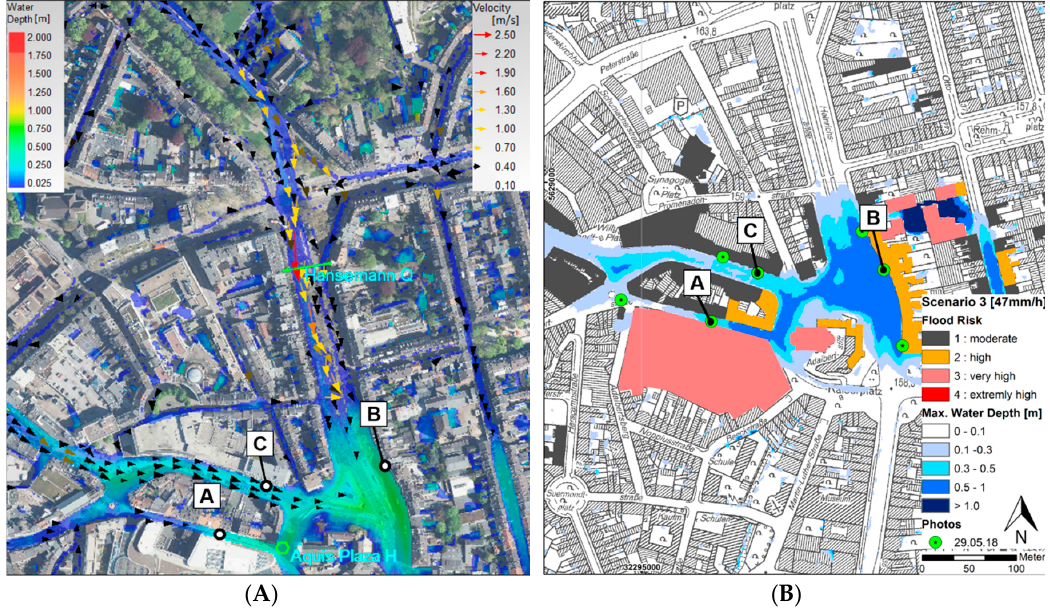
Figure 6. ( A ) Simulated flood depths and flow velocities (timestep: 70 min after simulation start); ( B ) Systematic risk map of scenario 3 inclusive photos in the city center of Aachen